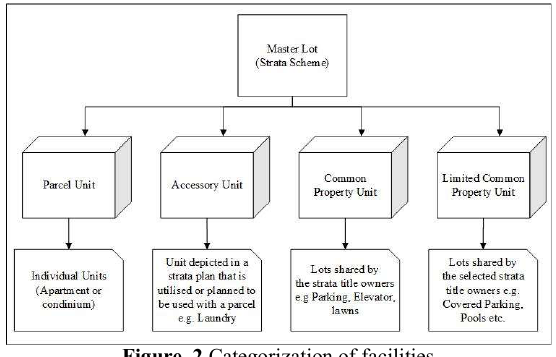
Figure. 2 Categorization of